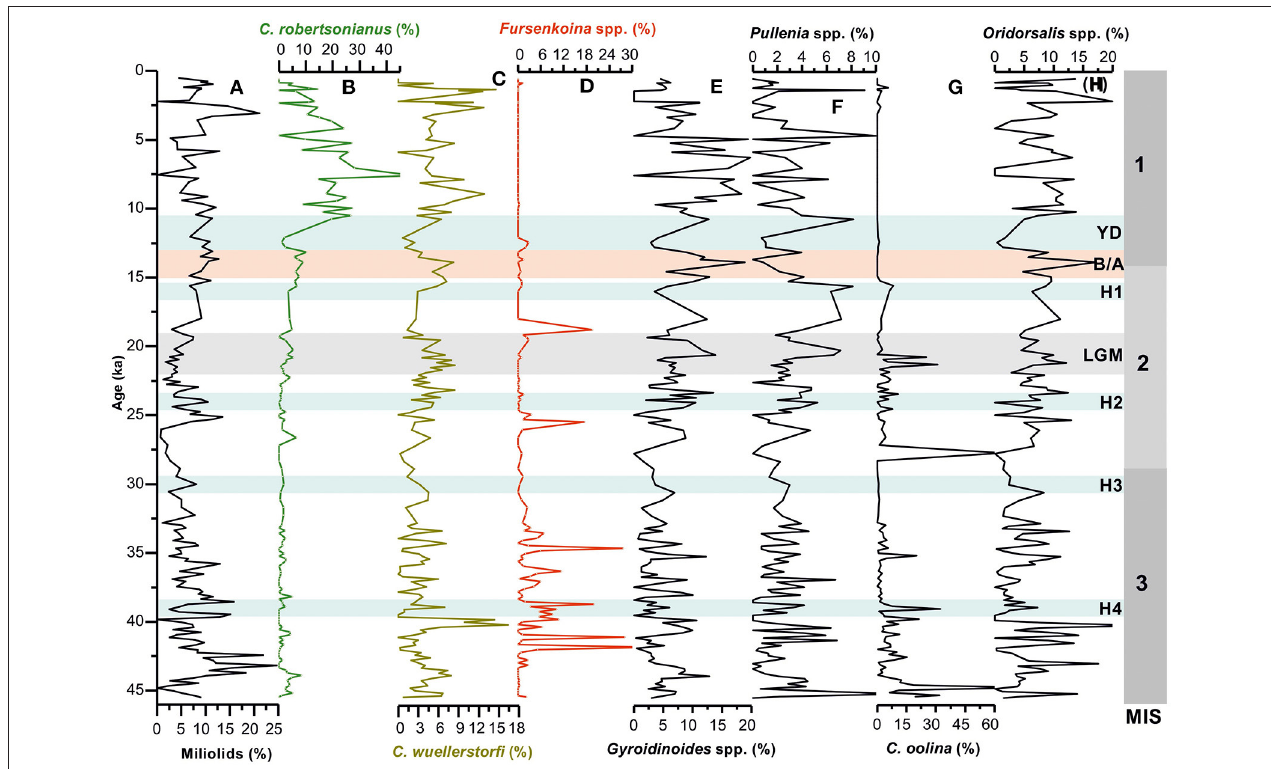
FIGURE 3 | Temporal variations in relative abundances of (A) total miliolids; (B,C) cibicidid species ( C. wuellerstorfi and C. robertsonianus ); (D) Fursenkoina spp., (E) Gyroidinoides spp., (F) Pullenia spp., (G) Chillostomella oolina , and (H) Oridorsalis spp. in core SK 218/1. MIS 1–3 denotes the Marine Isotope Stages; H1–H4, Heinrich Events; YD, Younger Dryas; B/A, Bølling/Allerød; LGM, Last Glacial Maxima.